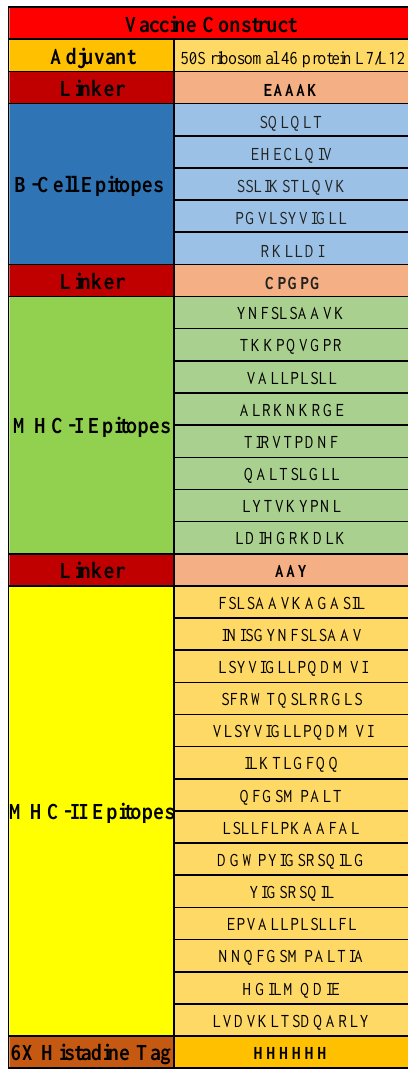
Figure 3. Vaccine Construct against the Nucleocapsid protein; 5 B-Cell Epitopes, 8 MHC-I epitopes, and 14 MHC-II epitopes.